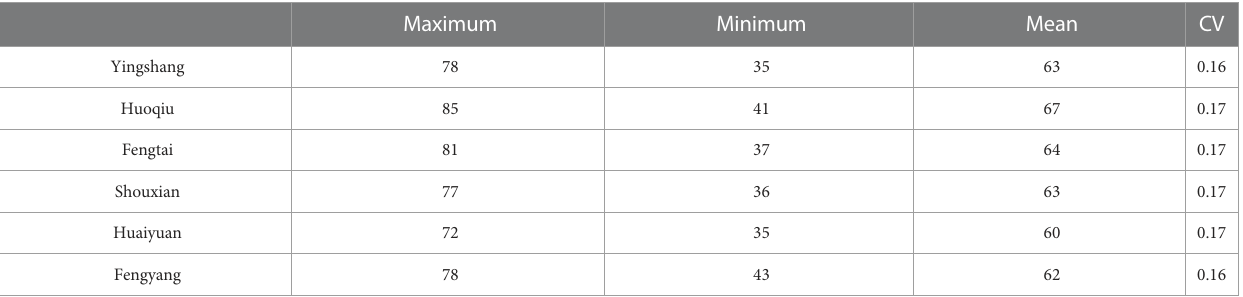
TABLE 5 Annual precipitation days with regards to the whole wheat growing season from 1999 to 2020 at six meteorological stations i.e. Yingshang, Huoqiu, Fengtai, Shouxian, Huaiyuan, and Fengyang, located in Yanhuai